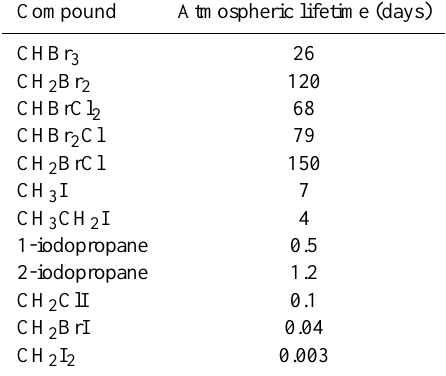
Table 1. Naturally produced short-lived halocarbons and their esti- mated global atmospheric lifetime (Law and Sturges,